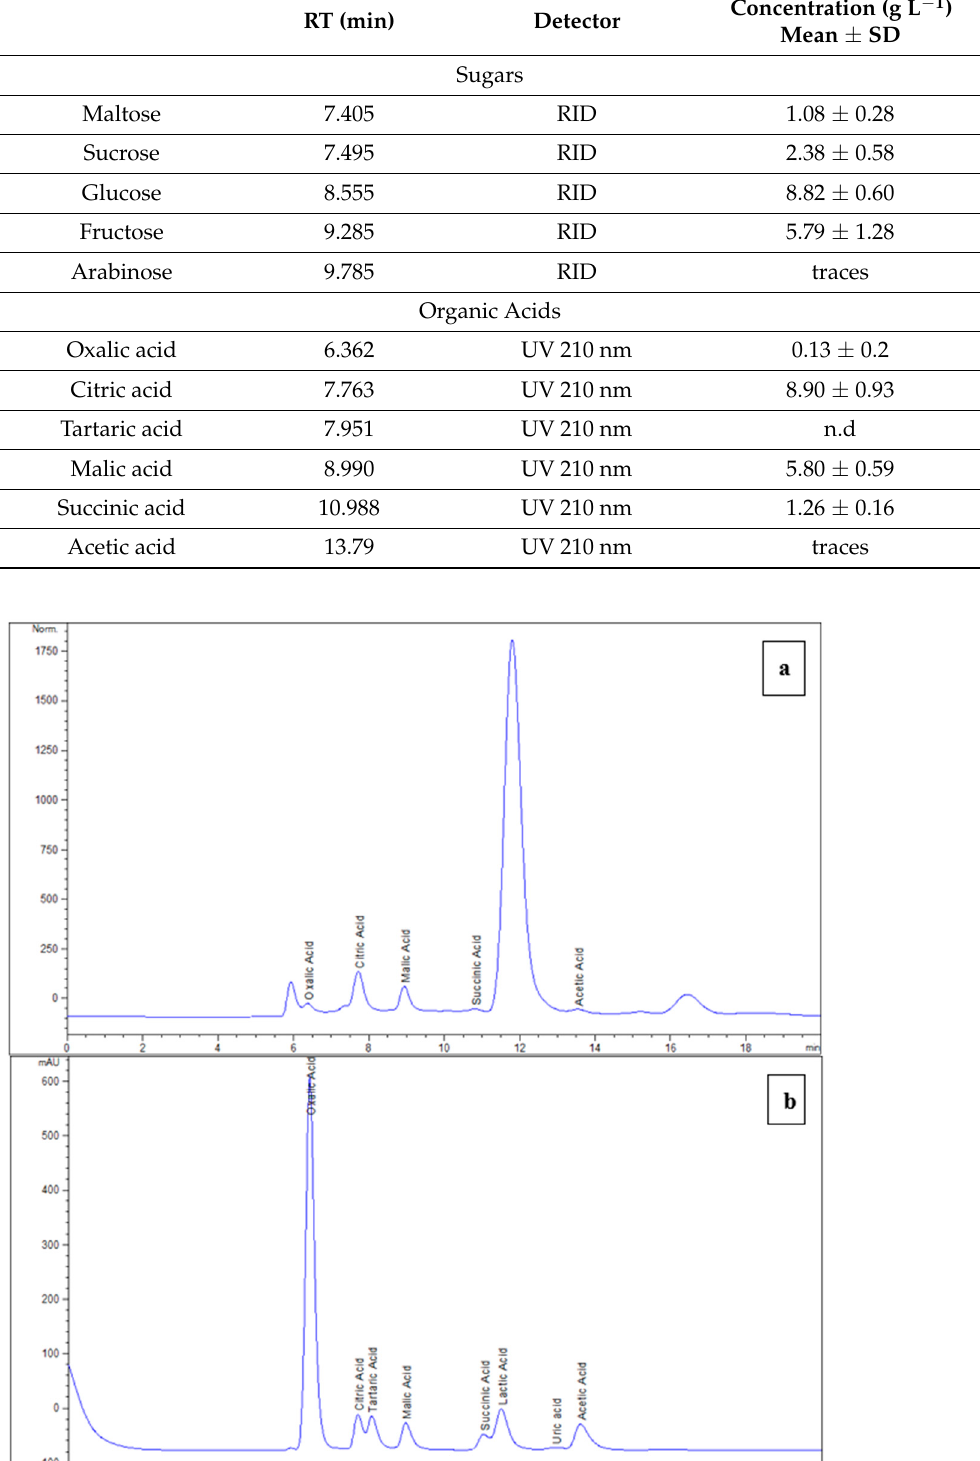
Table 2. Sugars and organic acids determined by HPLC analyses in cladode juice of O. ficus-indica.